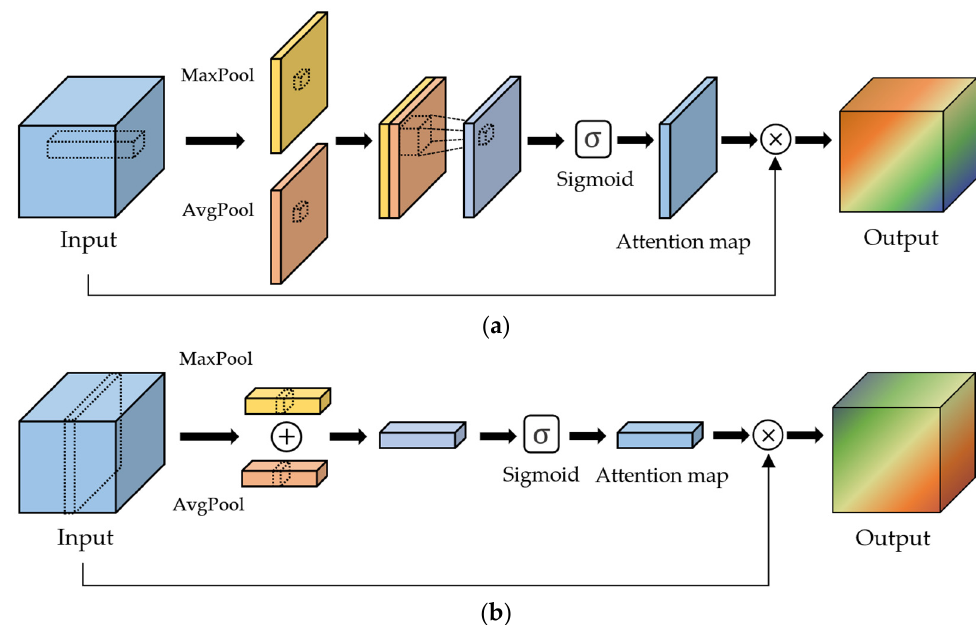
Figure 2. Spatial and channel attention to assign different priorities of input feature maps. ( a ) Spatial attention and ( b ) channel attention.